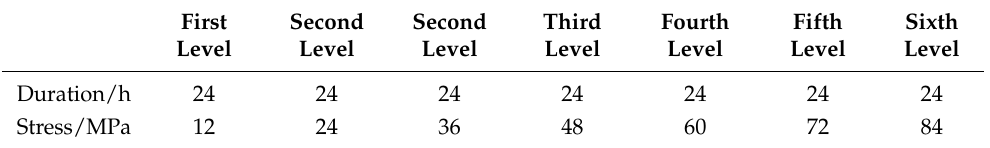
Table 2. Level of stress.